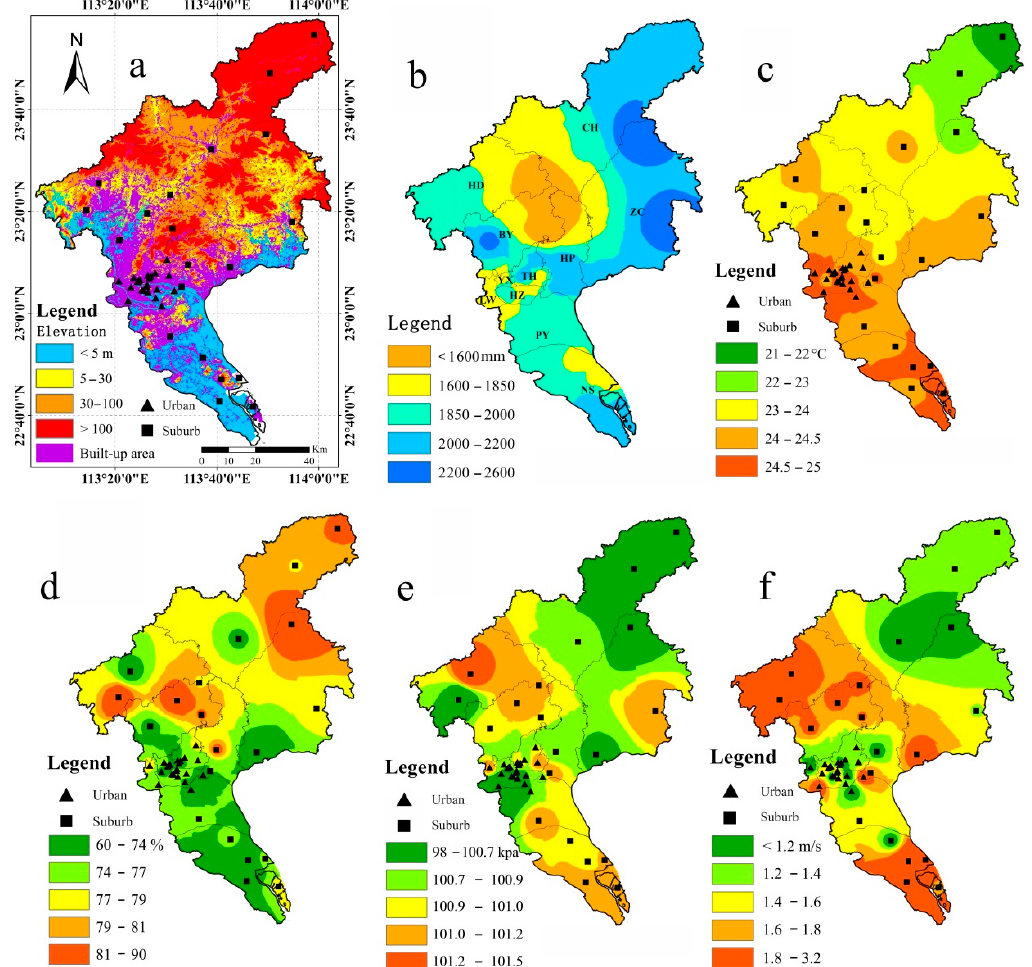
Figure 2. The elevation and built-up areas of Guangzhou and the locations of the meteorological sites ( a ), annual total rainfall ( b ), annual mean air temperature ( c ), relative humidity ( d ), air pressure ( e ), and wind speed ( f ) for two complete years from July 2015 to June